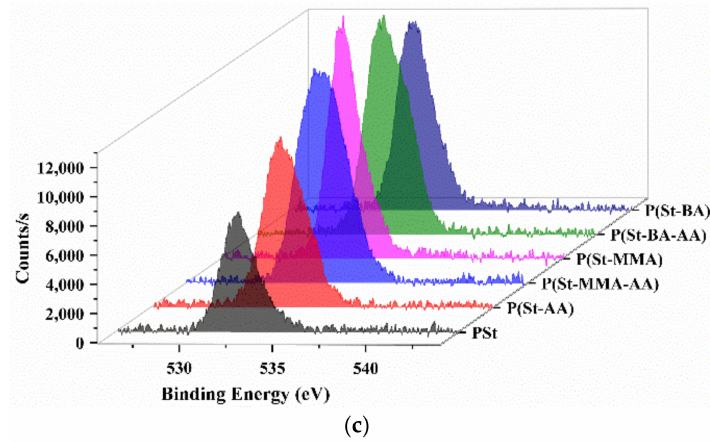
Figure 1. XPS spectra of six types of PSt-based microspheres; ( a ) wide-scan spectra, ( b ) C1s spectra, and ( c ) O1s